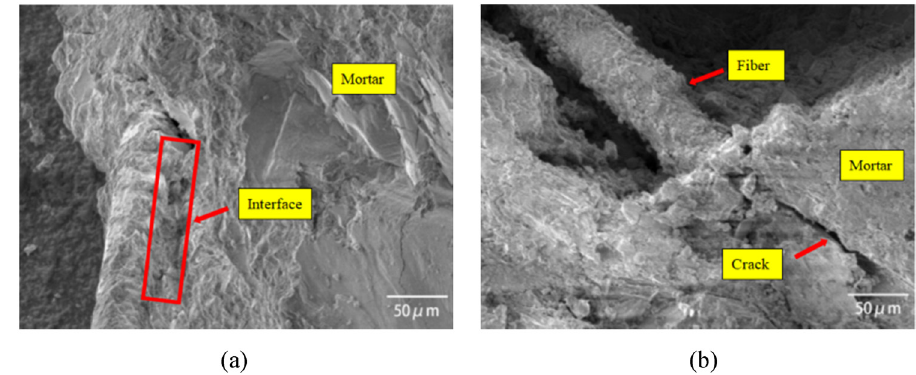
Figure 6: The SEM images of PVA fi ber in B 1 specimen. ( a ) Fiber surface and ( b ) fi ber port.